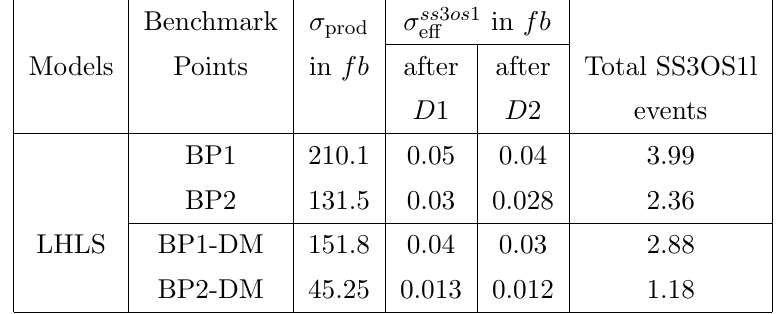
Table 16 . The production cross sections of all EWeakino pairs and (cid:27) ss 3 os 1 for the BPs de(cid:12)ned in table 6 and table 8. Also the total number of SS3OS1l events are shown for an integrated luminosity of 100 fb (cid:0) 1